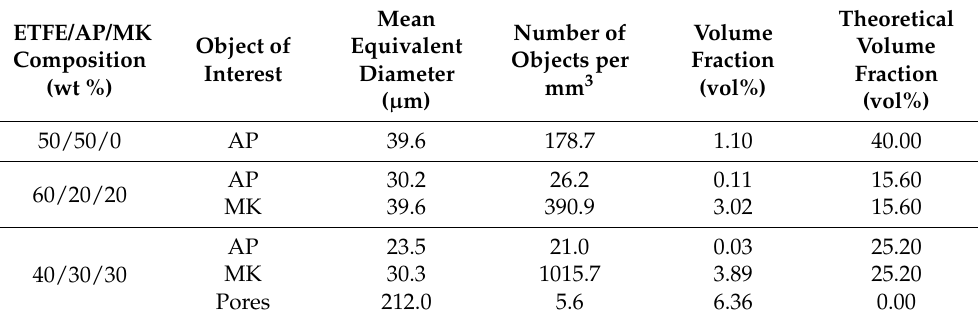
Table 4. Analysis of the polyoxides and pores in selected ETFE/AP/MK composites from µ CT measurements.